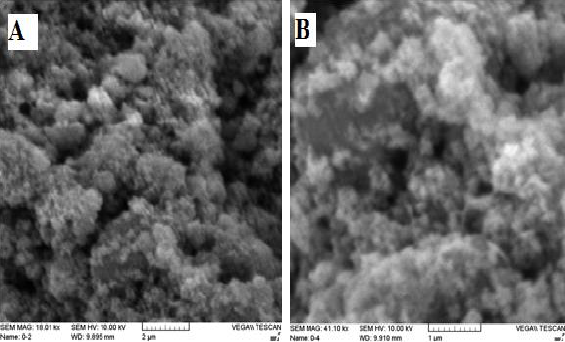
Figure, 1 A and B: Shows the images of SEM of ZnO